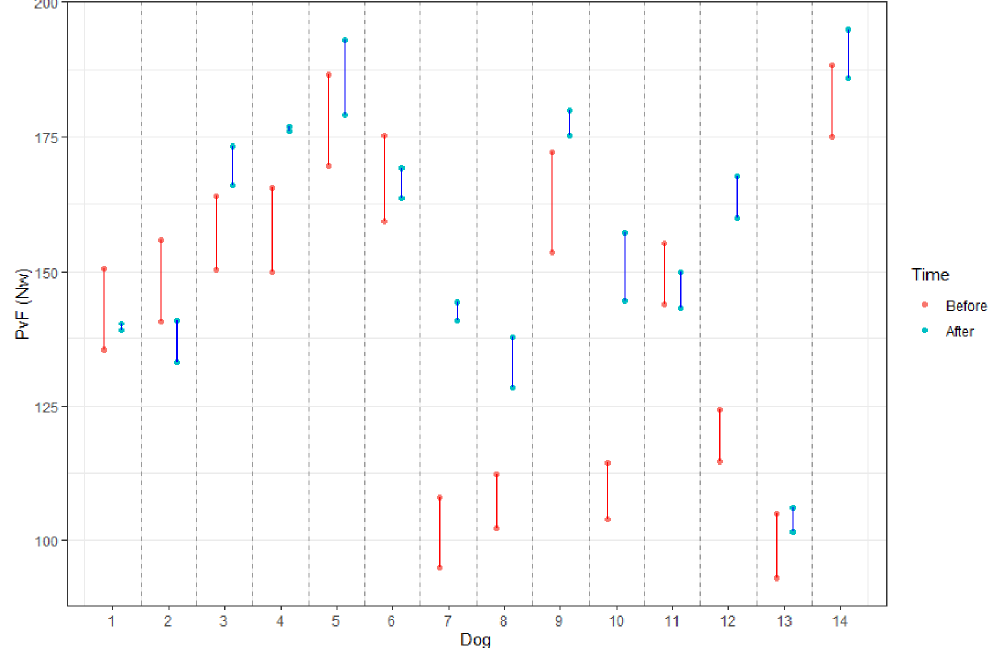
Figure 3. PVF obtained from LL and CL of each dog before (red) and after (blue) the treatment. The dog’s id number was randomly assigned.